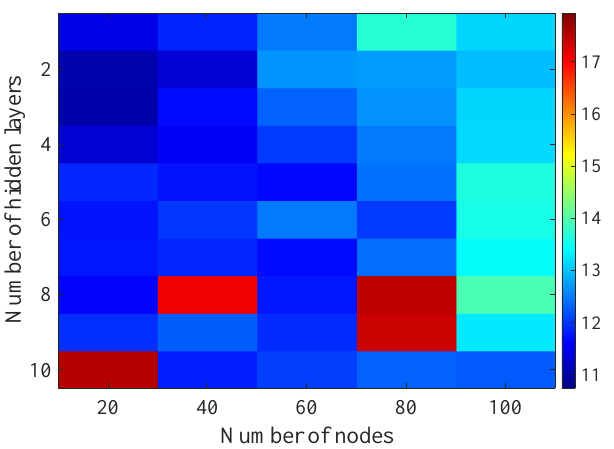
Figure 18. Matrix of the BLER RMSE metric predictions for the radio parameters history window W = 25 in the second stage learning process.